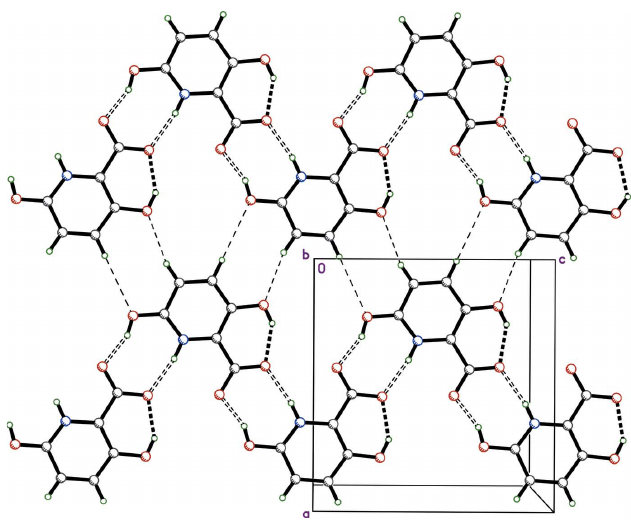
Figure 6 A view of the planar diperiodic network in crystalline II , viewed normal to the ac plane. Intramolecular hydrogen bonds are drawn as thick dashed lines, strong intermolecular hydrogen bonds (O—H (cid:2)(cid:2)(cid:2) O and N—H (cid:2)(cid:2)(cid:2) O) are drawn as double dashed lines. Weaker hydrogen bonds (C—H (cid:2)(cid:2)(cid:2) O) are drawn as thin dashed